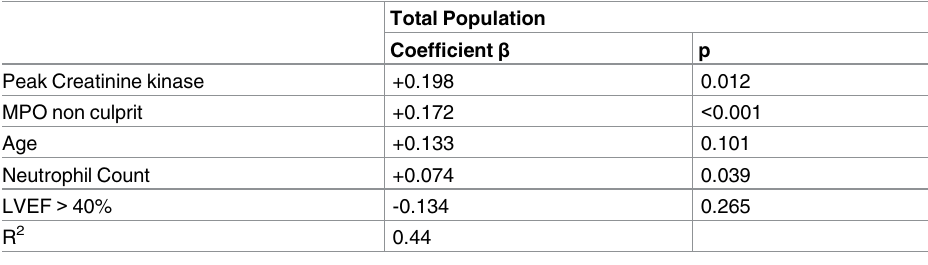
LVEF: Left Ventricular Ejection